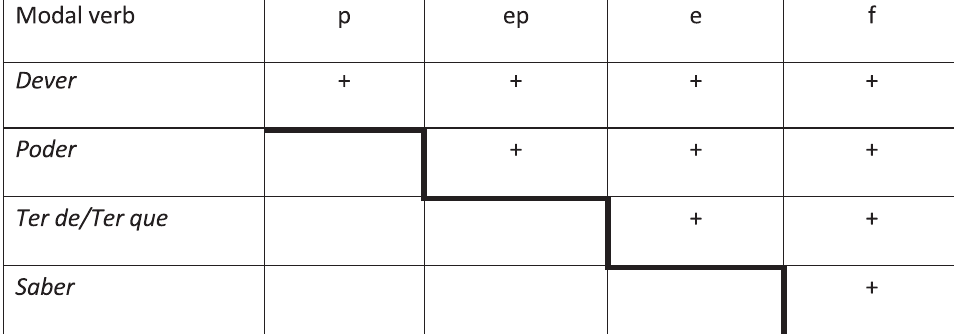
Figure 1: Distribution of modal verbs across layers.